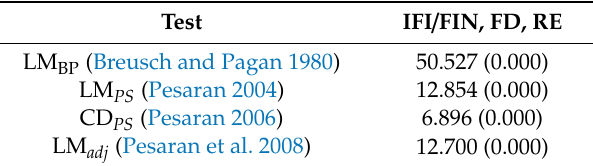
Table 3. Cross section dependency